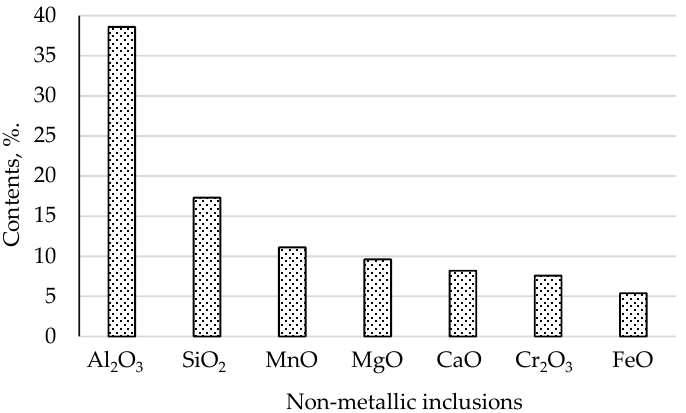
Figure 3. Exemplary results of the qualitative and quantitative analysis of non-metallic inclusions in